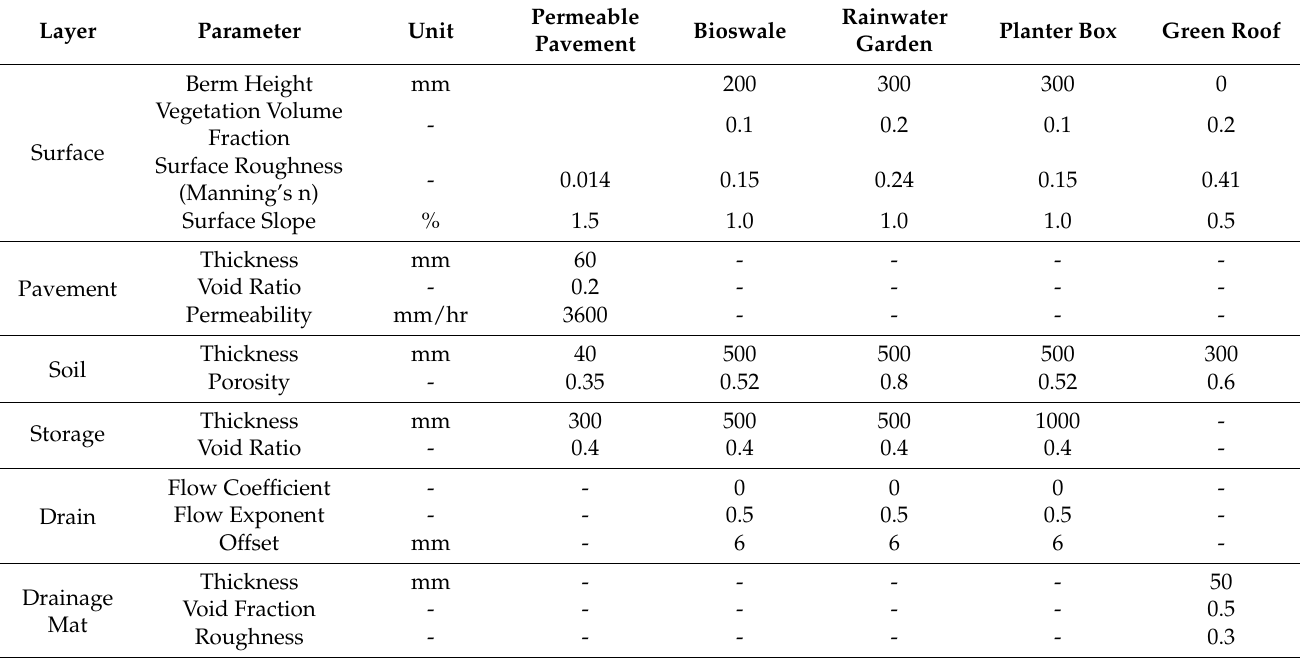
Table 7. Parameter values of the LID design.